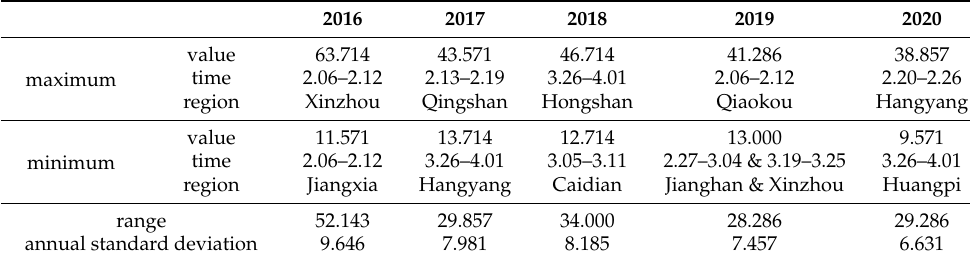
Table 7. CO maximum/minimum statistics from 2016 to 2020.